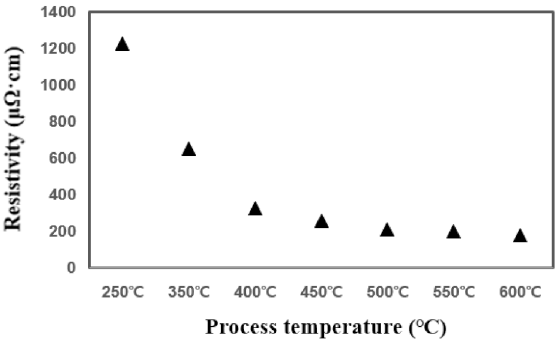
Figure 2. Comparison of resistive properties of TiN thin films over process